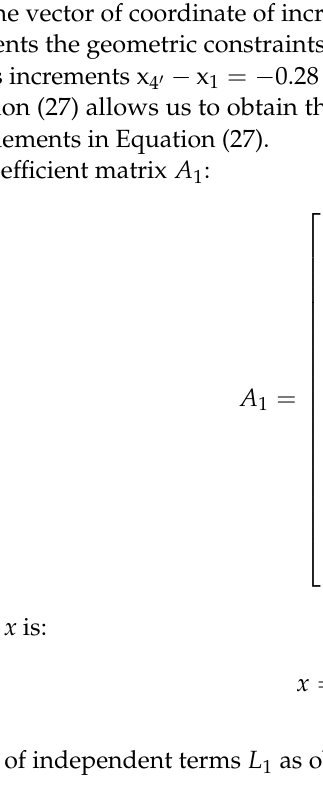
Figure 5. Vertex positions 1, 4 (cid:48) , and 5 (cid:48) . Distances d = d 14 (cid:48) = d 15 (cid:48) = 0.40 m. Coordinate increments: d 1 = ∆ X 14 (cid:48) = − 0.28 m, d 2 = ∆ Y 14 (cid:48) = 0.28